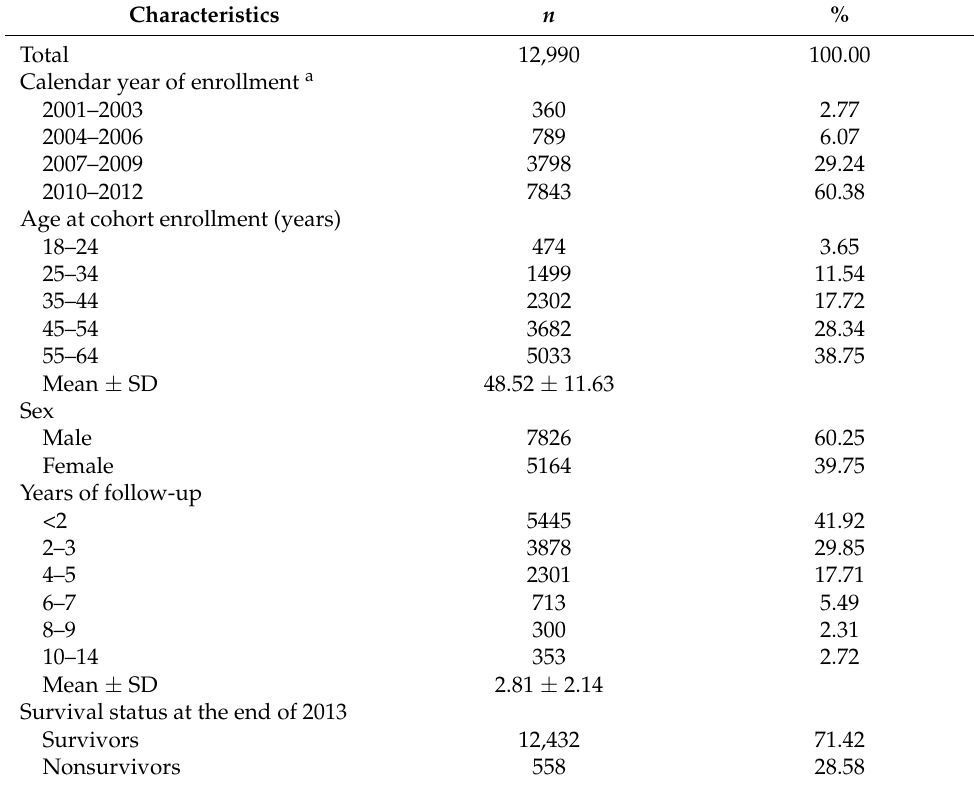
Table 1. Characteristics of the study